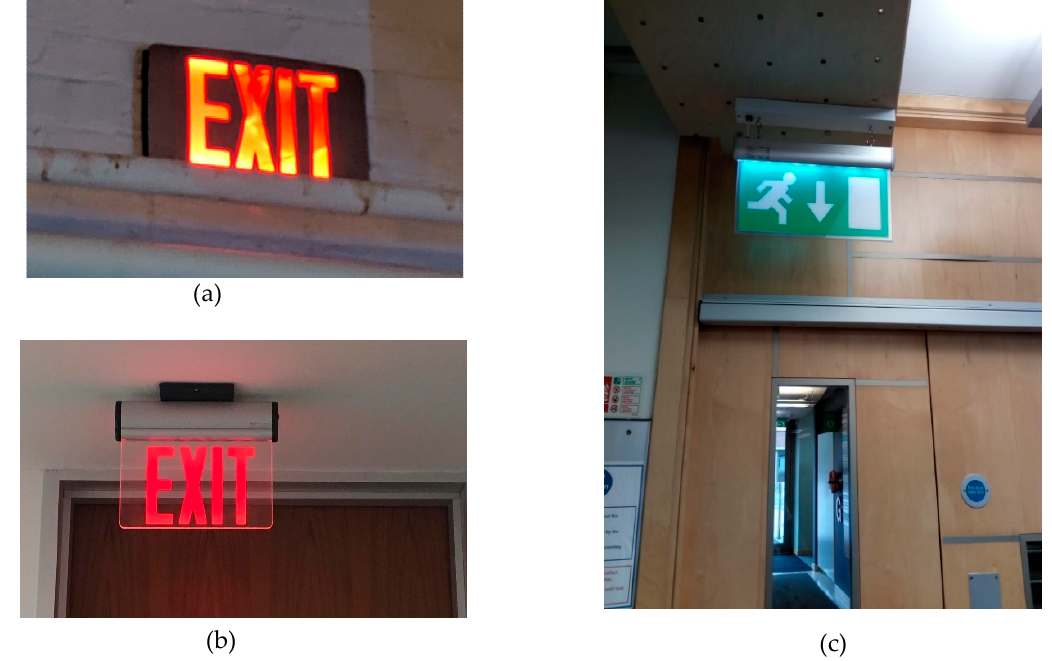
Figure 19. ( a , b ) American and ( c ) UK fire exit signs found inside o ffi ces. Permission grant and Figure 19. (a,b) American and (c) UK fire exit signs found inside offices. Permission grant and photographs taken by Sharp, Romero and photographs taken by Sharp, Romero and Henry-Edwards Scenario #6—Homeless Community